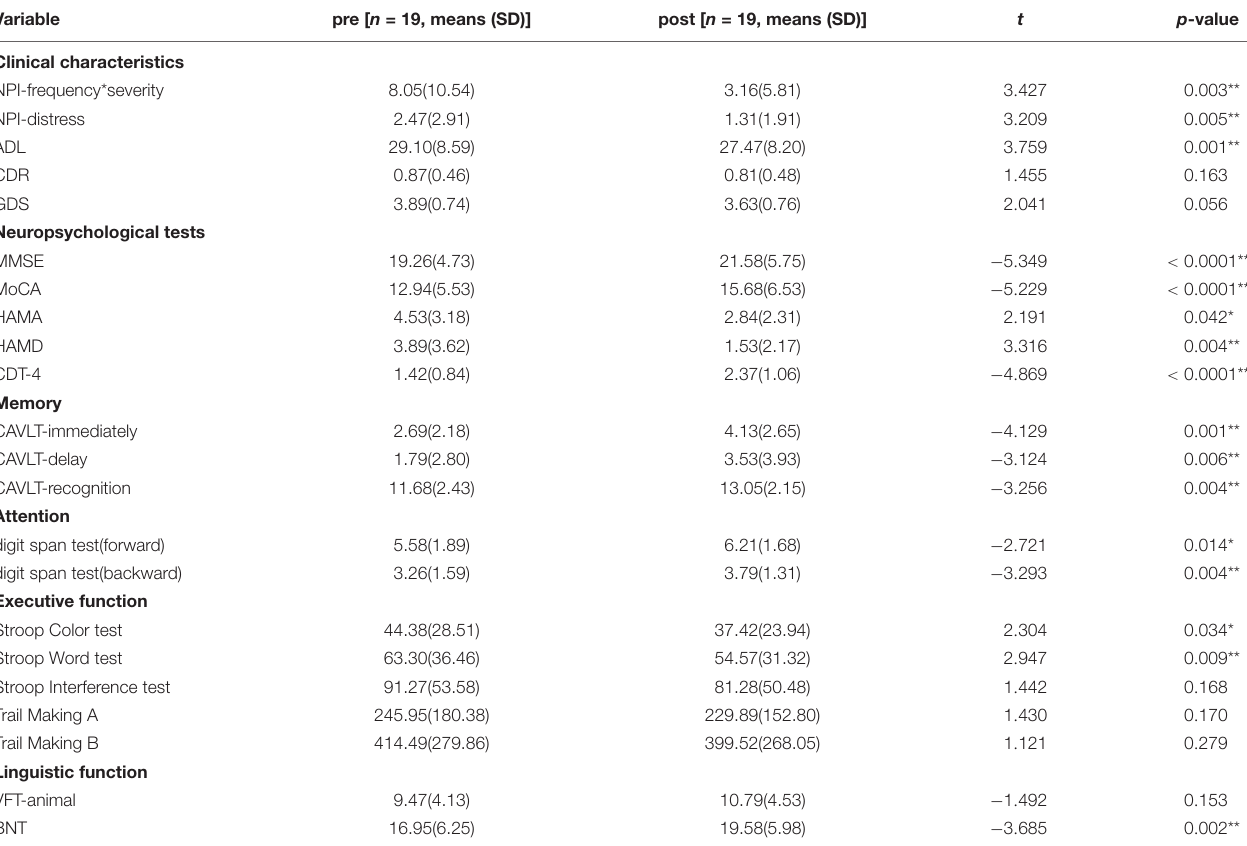
TABLE 3 | Improvement clinical characteristics and cognitive function after iTBS treatment in AD patients.